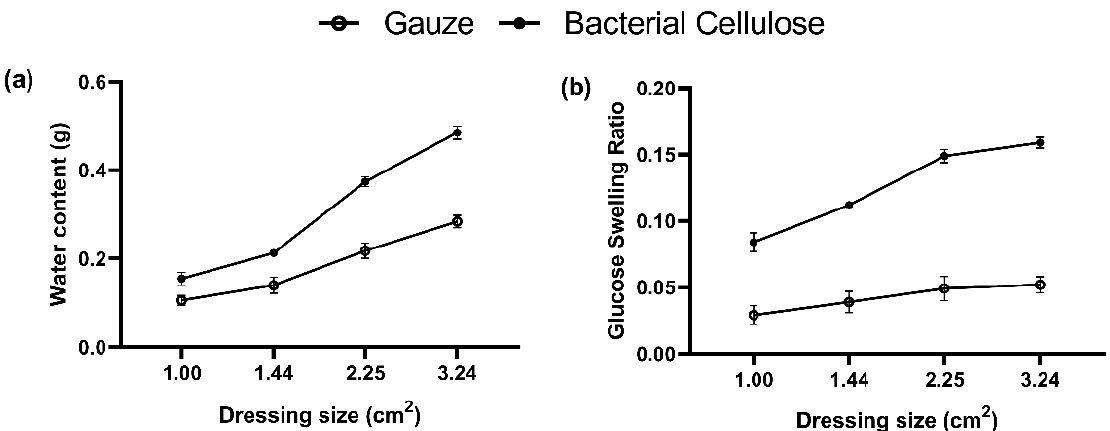
Figure 8. Water absorption capacity ( a ) and glucose swelling ratio ( b ) of gauze (open circle) and the bacterial cellulose (close circle) of different areas. Dried gauze ( n = 20) and bacterial cellulose ( n = 20) were cut into pieces of different areas and weighed. The pieces were then placed in Petri dishes, soaked in pure water and glucose solution, and sealed for 24 and 48 h, respectively. They were then weighed and measured individually to calculate the difference before and after to determine the water absorption content and glucose swelling ratio. Error bars of means ±S.D.